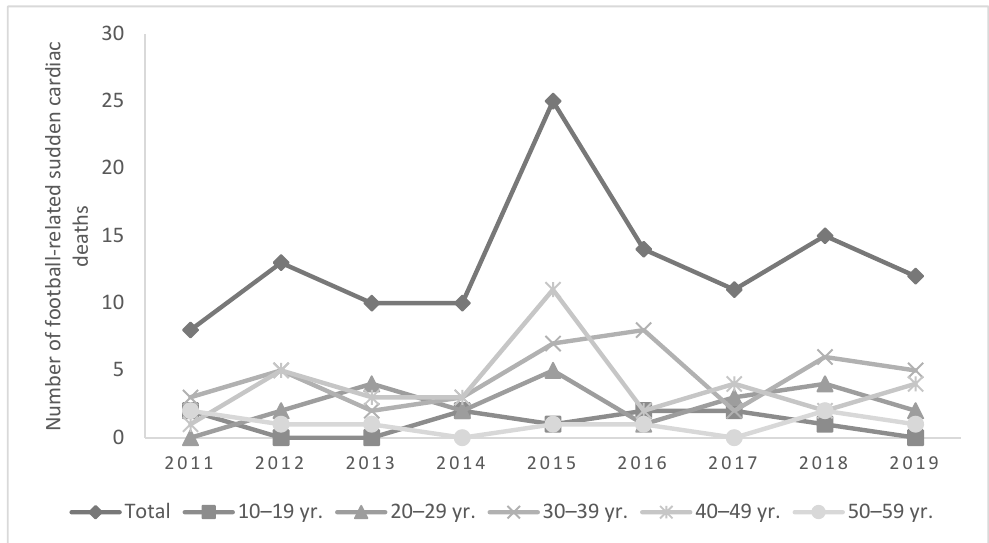
Figure 1. Number of football-related sudden cardiac death in Turkey by year (2011 – 2019). Yr: years of age.